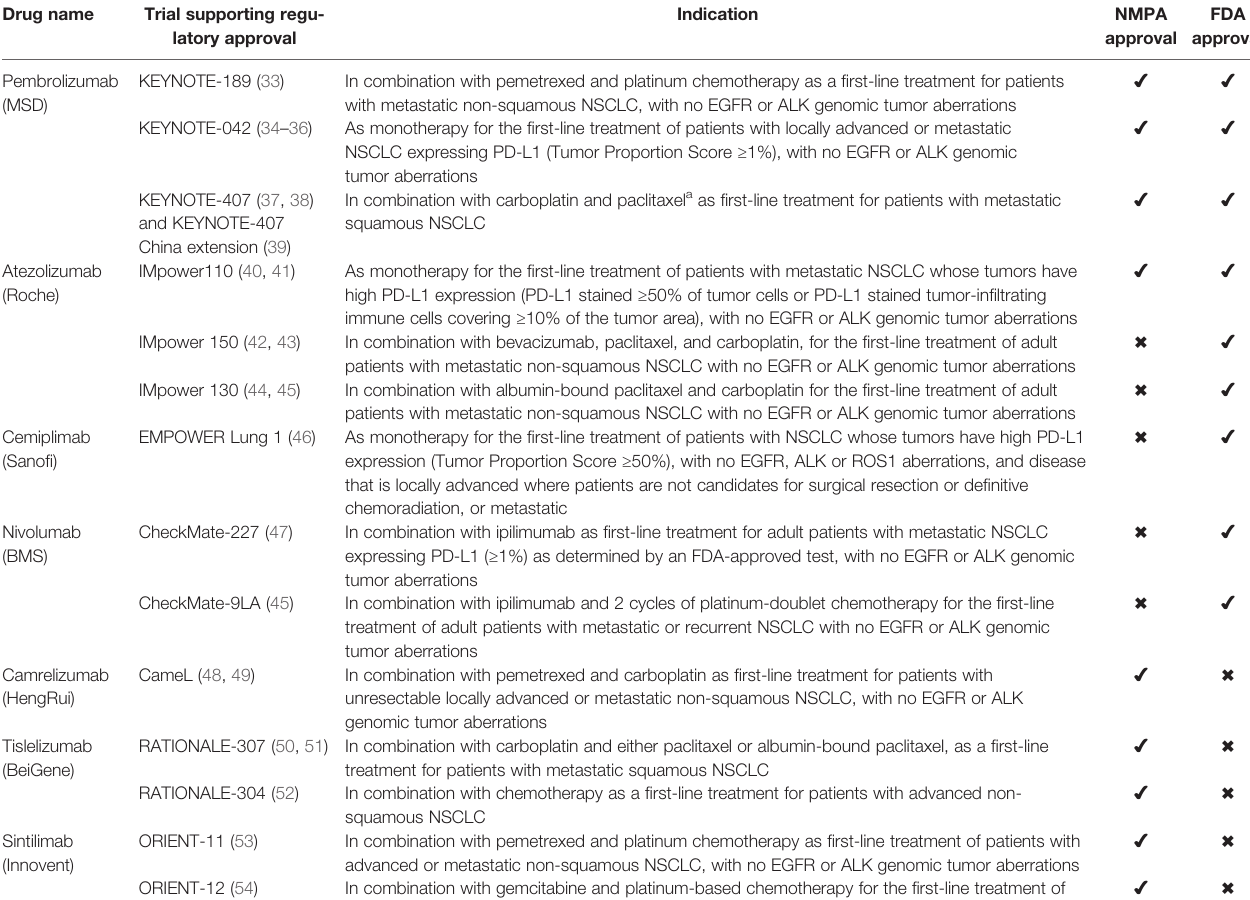
TABLE 1 | Summary of approval status, indications and supporting clinical trials for immune therapies that are approved for use in patients with